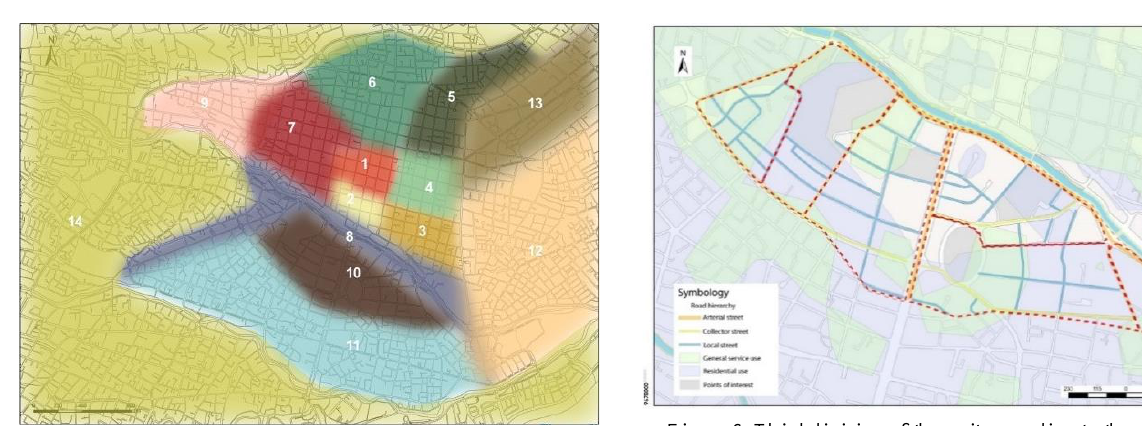
Figure 5. Landscape units 8, 10, 11 that make up the area of El Ejido. Source: Siguencia, 2014.